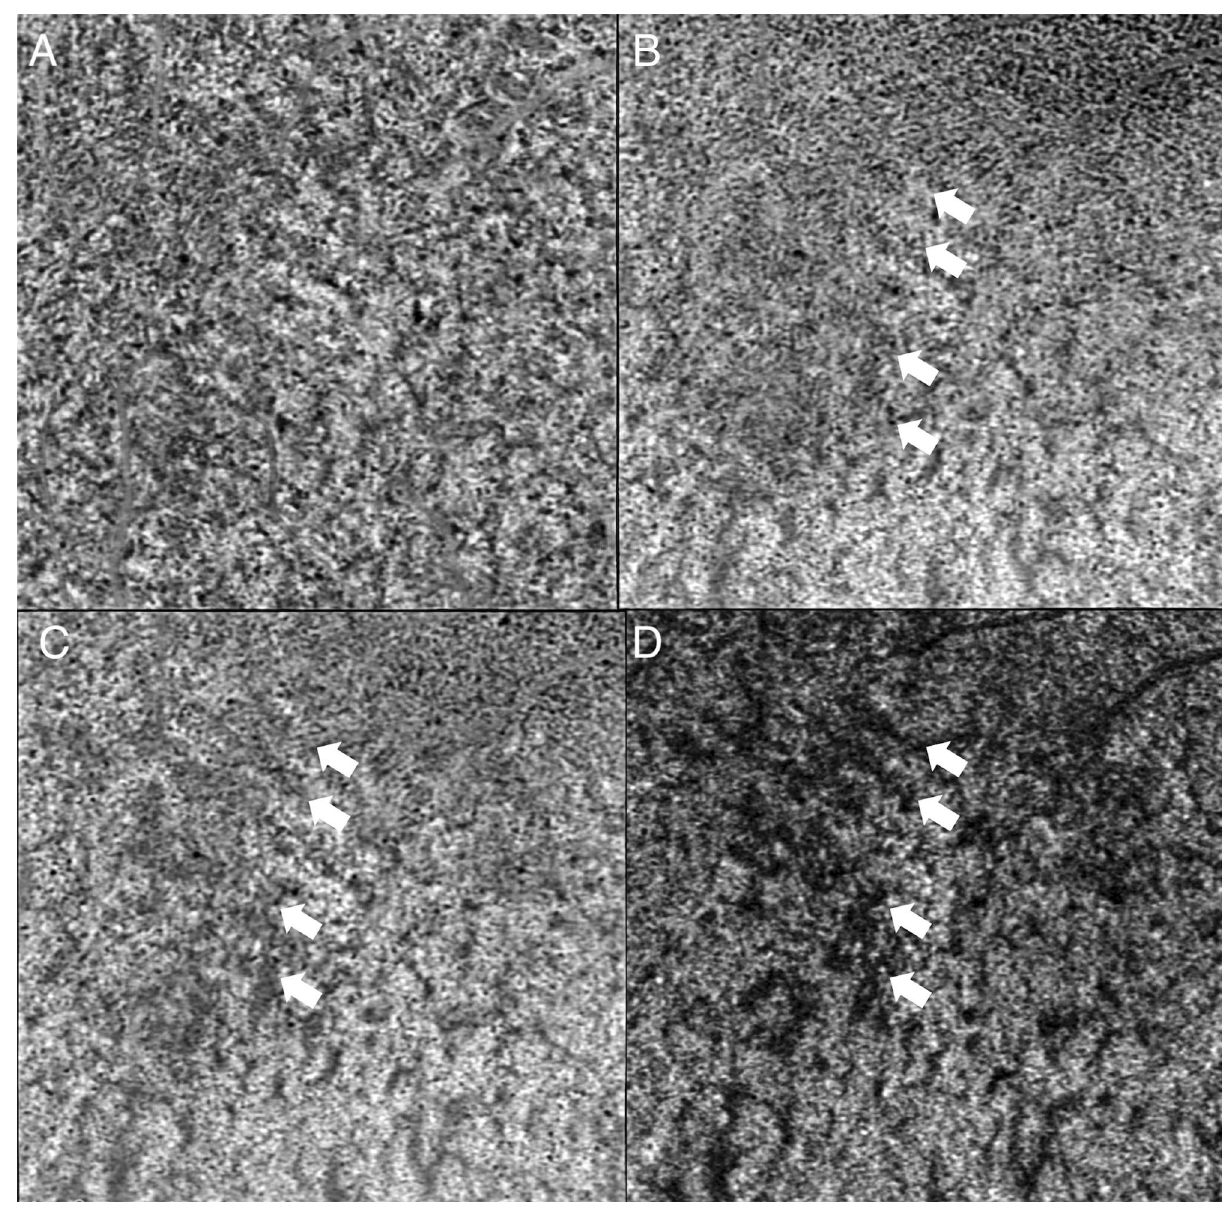
Figure 5. Optical coherence tomography angiography of a 3 × 3 mm area centered over the fovea of the same eye as in Fig. 1. ( A ) showed choriocapillaris slab using boundaries of 17 µm below RPE to 33 µm below RPE. A uniform meshwork of bright areas which appear as continuous densely packed capillary network can be seen. This network appeared to have uniform characteristics in vessel density and size. In particular, a specific lobular or segmented structure was not a dominant feature. Additional slabs to visualize the posterior part of choriocapillaris using boundaries of 20–28 µm below RPE ( B ) and 26–33 µm below RPE ( C ) also showed a uniform meshwork as the dominant feature. Several tubular structures (arrow) can be seen which correlate to choroidal vessels which appear black in the slab with boundaries 25–40 µm below RPE ( D